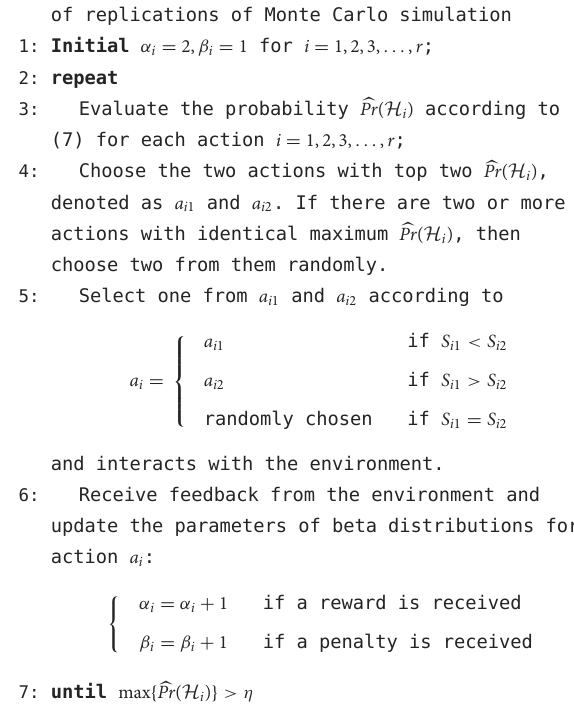
Algorithm 1. Parameter-free learning automaton.